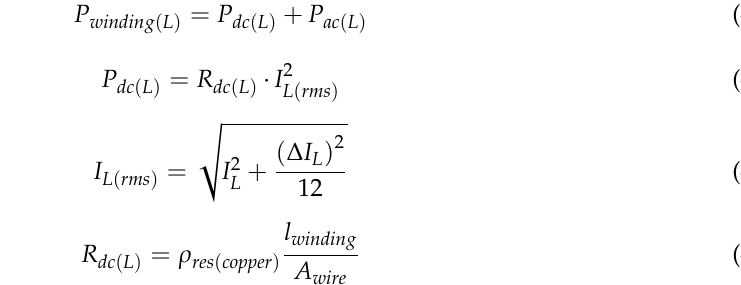
Table 5. Current calculation for MOSFET (lower side) and diode (upper side) in boost operation with an average inductor current I L = P nom , the inductor current ripple ∆ I L = D nom V in · N ph duty cycle D nom = 1 − V in V O